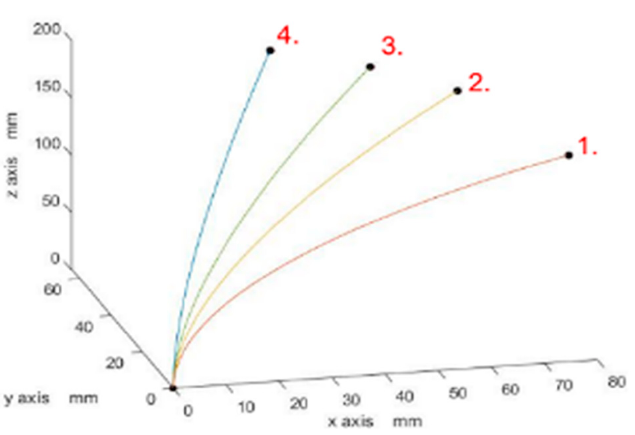
Figure 11. Simulation of the rotation angle ϕ of single CKM kinematic: 1. ϕ = 0; 2. ϕ = π /2; 3. ϕ = π /4; 4. ϕ = π /3.